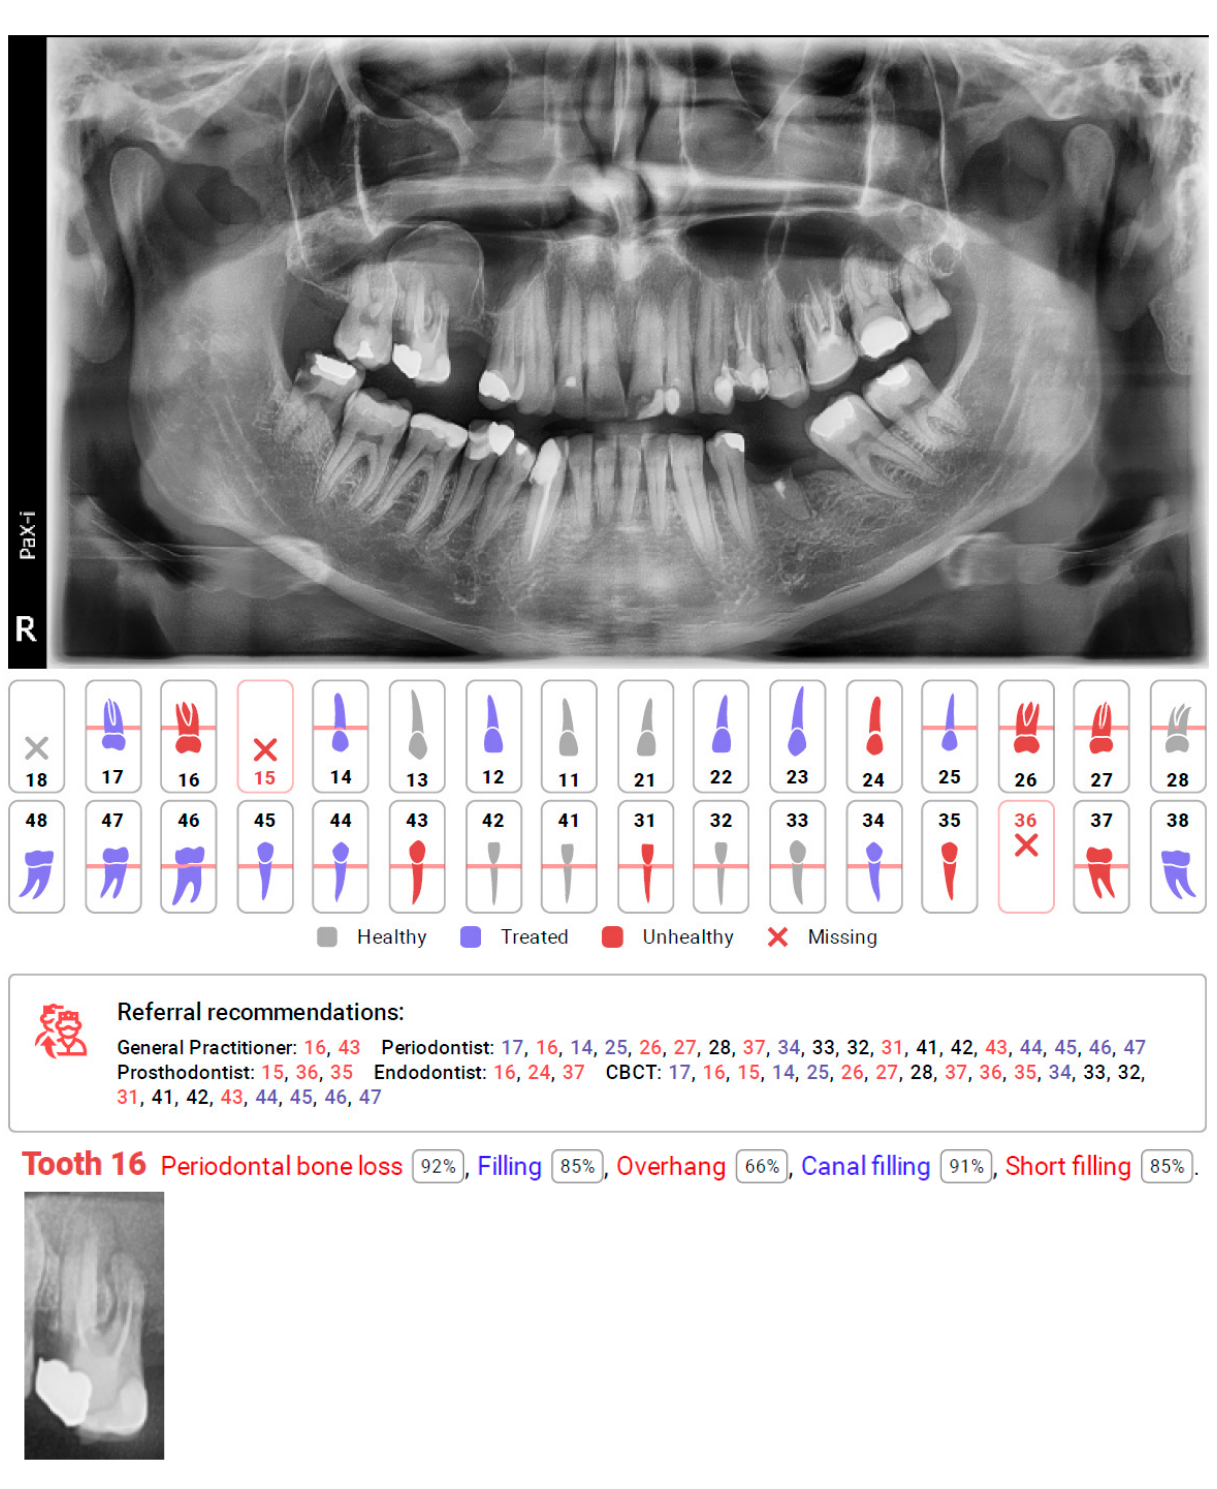
Figure 3. Diagnocat report, with missing detection of cyst in the right maxillary sinus in the region of tooth 16 and automating caption of tooth with detected other pathologies. Referral recommendations suggest additional CBCT diagnosis for this tooth as well as consultation with an